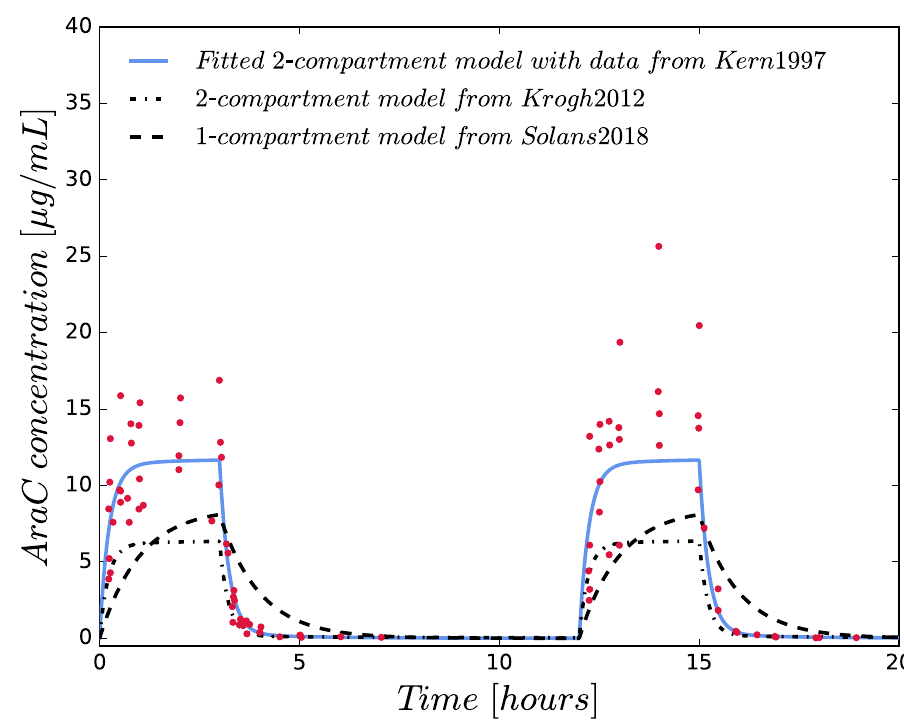
Fig 2. Simulations of different pharmacokinetic models and Ara-C concentration measurements from Kern et al . [39].